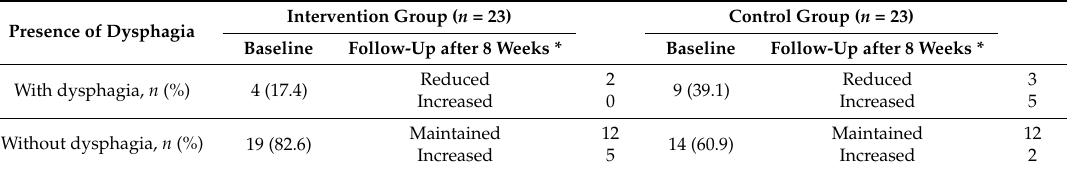
Table 2. Distribution of the presence of dysphagia and follow-up